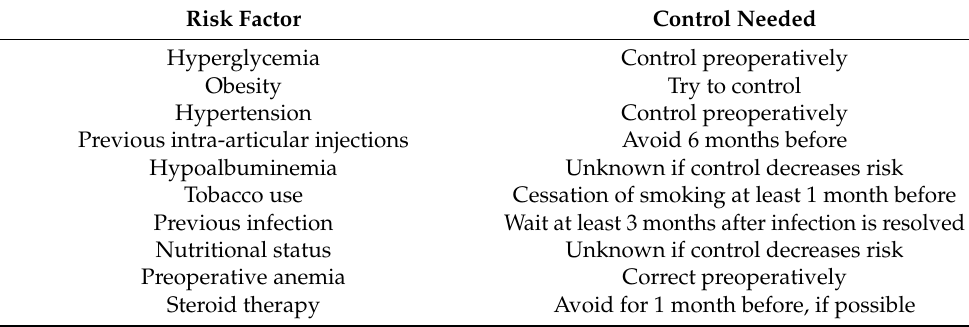
Table 4. Main modifiable risk factors of periprosthetic joint infection (PJI) before